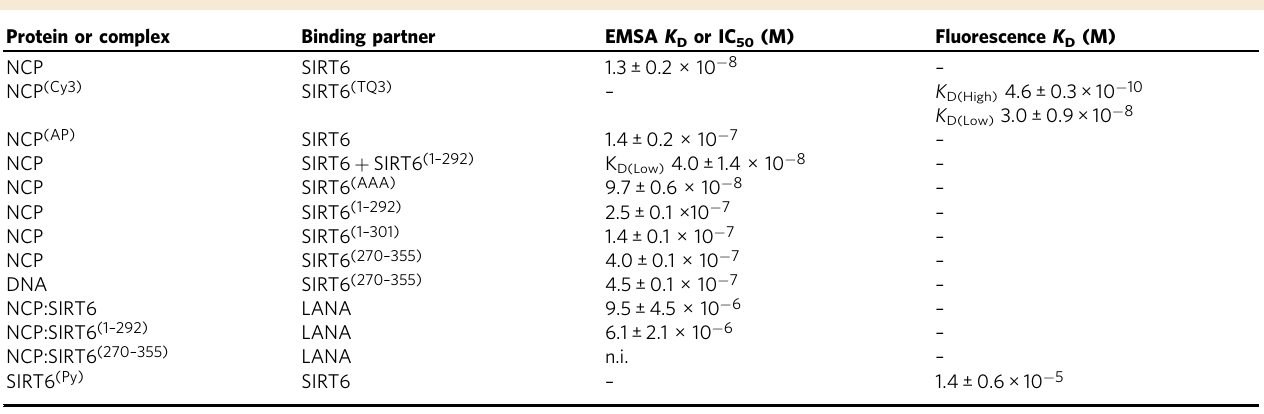
Table 1 K D and IC 50 values determined in this